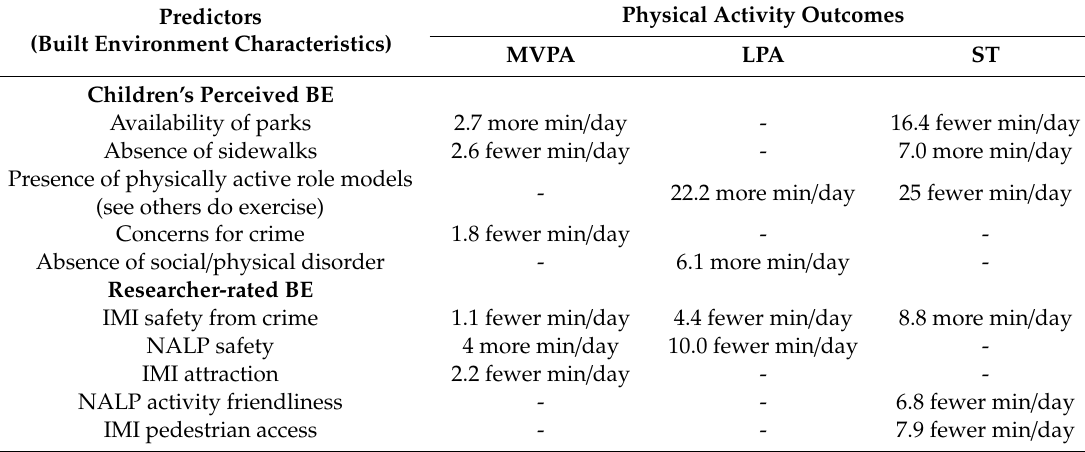
Table 5. Results across all PA levels and ST in relation to neighborhood BE